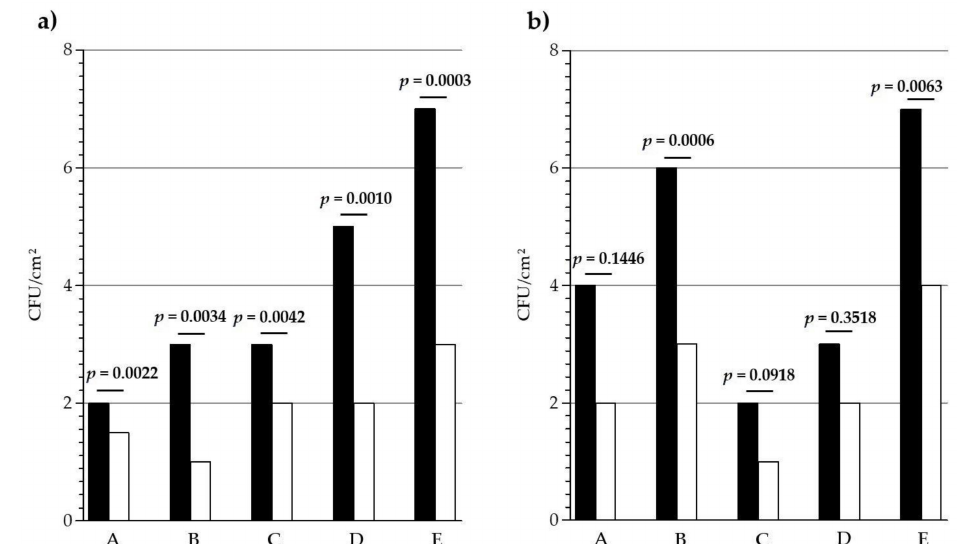
Figure 2. Bacterial burden recovered from ( a ) door handles and ( b ) handrails in each long-term care facility (A to E). Black bars, control; White bars, copper. 65 ≤ n ≤ 70. Median values.